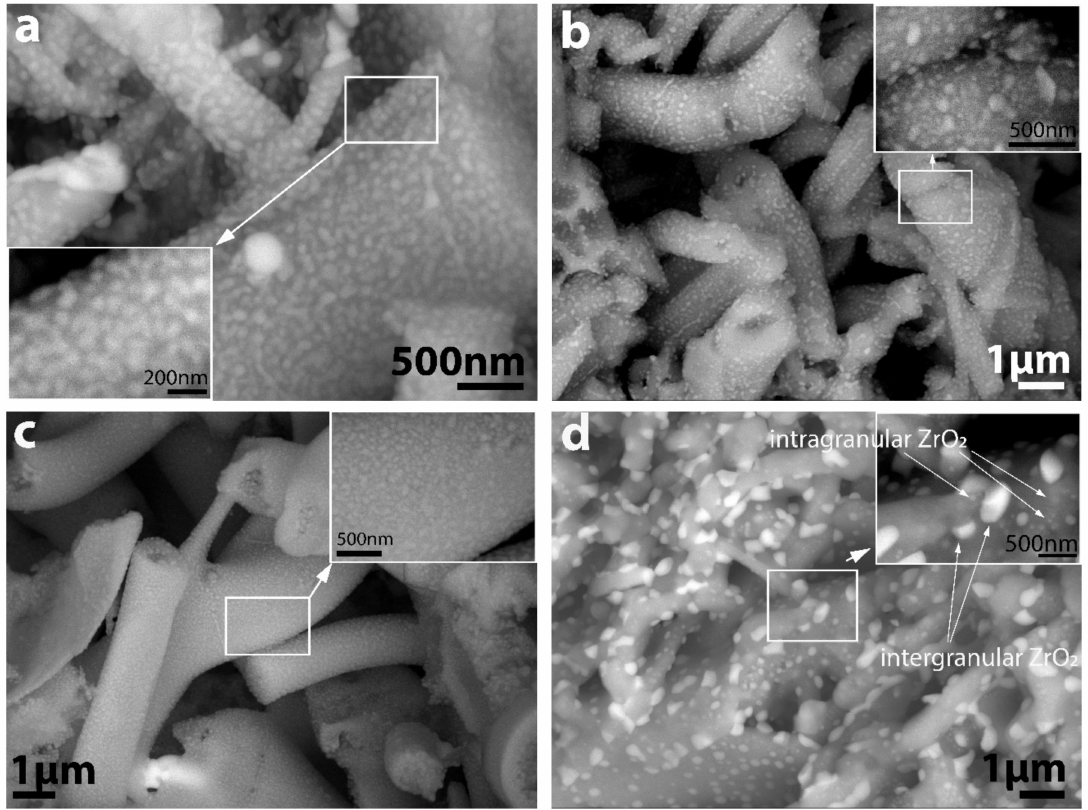
Figure 9. SEM-BSE micrographs of the fractured surface of ( a ) Y-ZTA STD, ( b ) Y-ZTA ASY, ( c ) Ce-ZTA STD, and ( d ) Ce-ZTA ASY at a 1300 ◦ C sintering